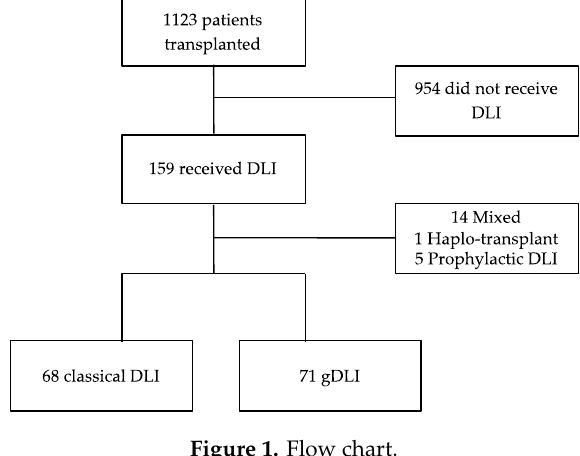
Figure 1. Flow chart.